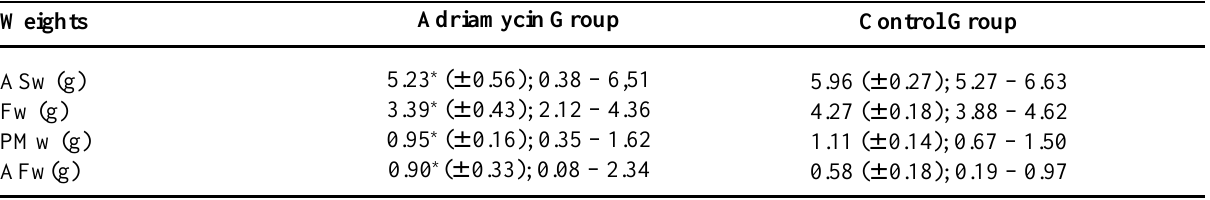
Table 2 – Comparison of weights. Mean, standard deviation and interval. Weights ASw (g) Fw